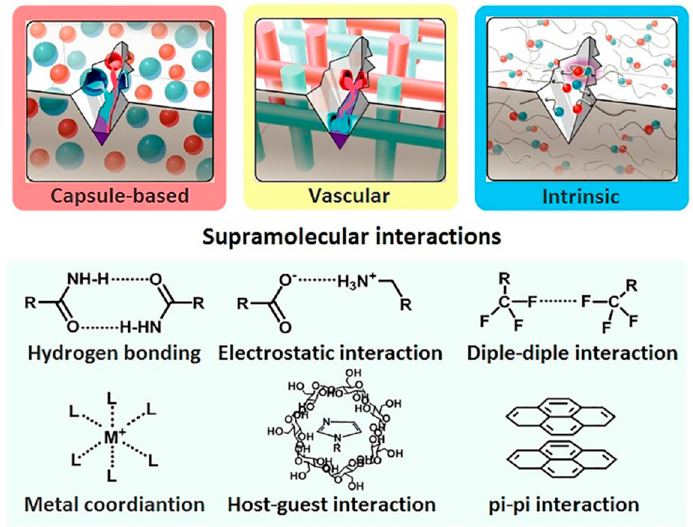
Figure 4. Typical self-healing modes and their chemical structures for self-healing [44]. Adapted from [44], with the permission of AIP Publishing.